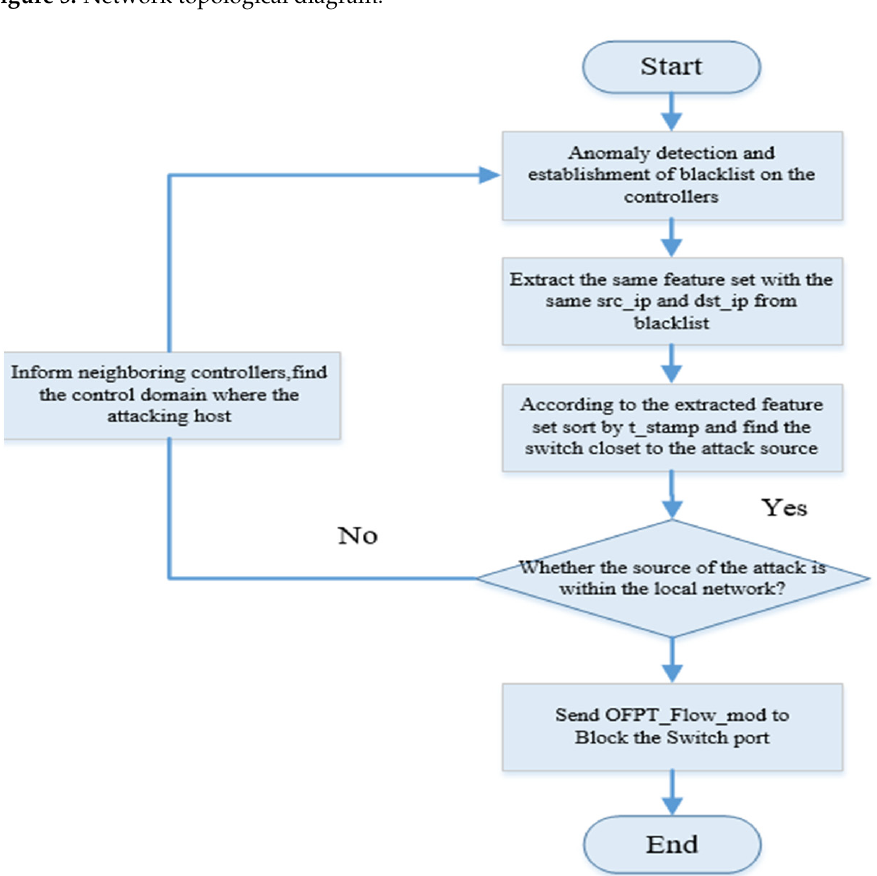
Figure 6. Flow chart of mitigation mechanism based on IP traceback. Table 3. IP traceback table for S5 in control domain 3.